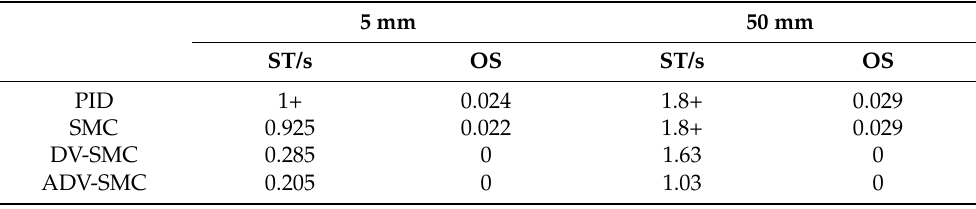
Table 2. Responses to step signal inputs.